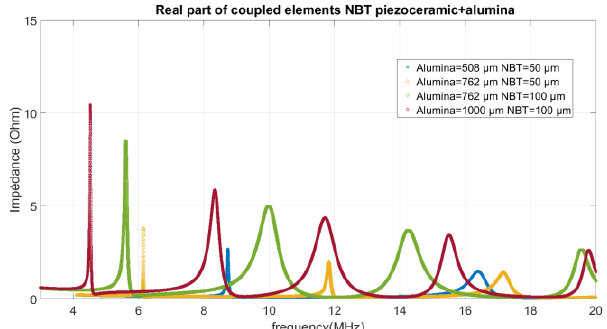
Figure 6 : Estimated real part of electrical impedance Vs frequency for various Alumina-NBT thickness